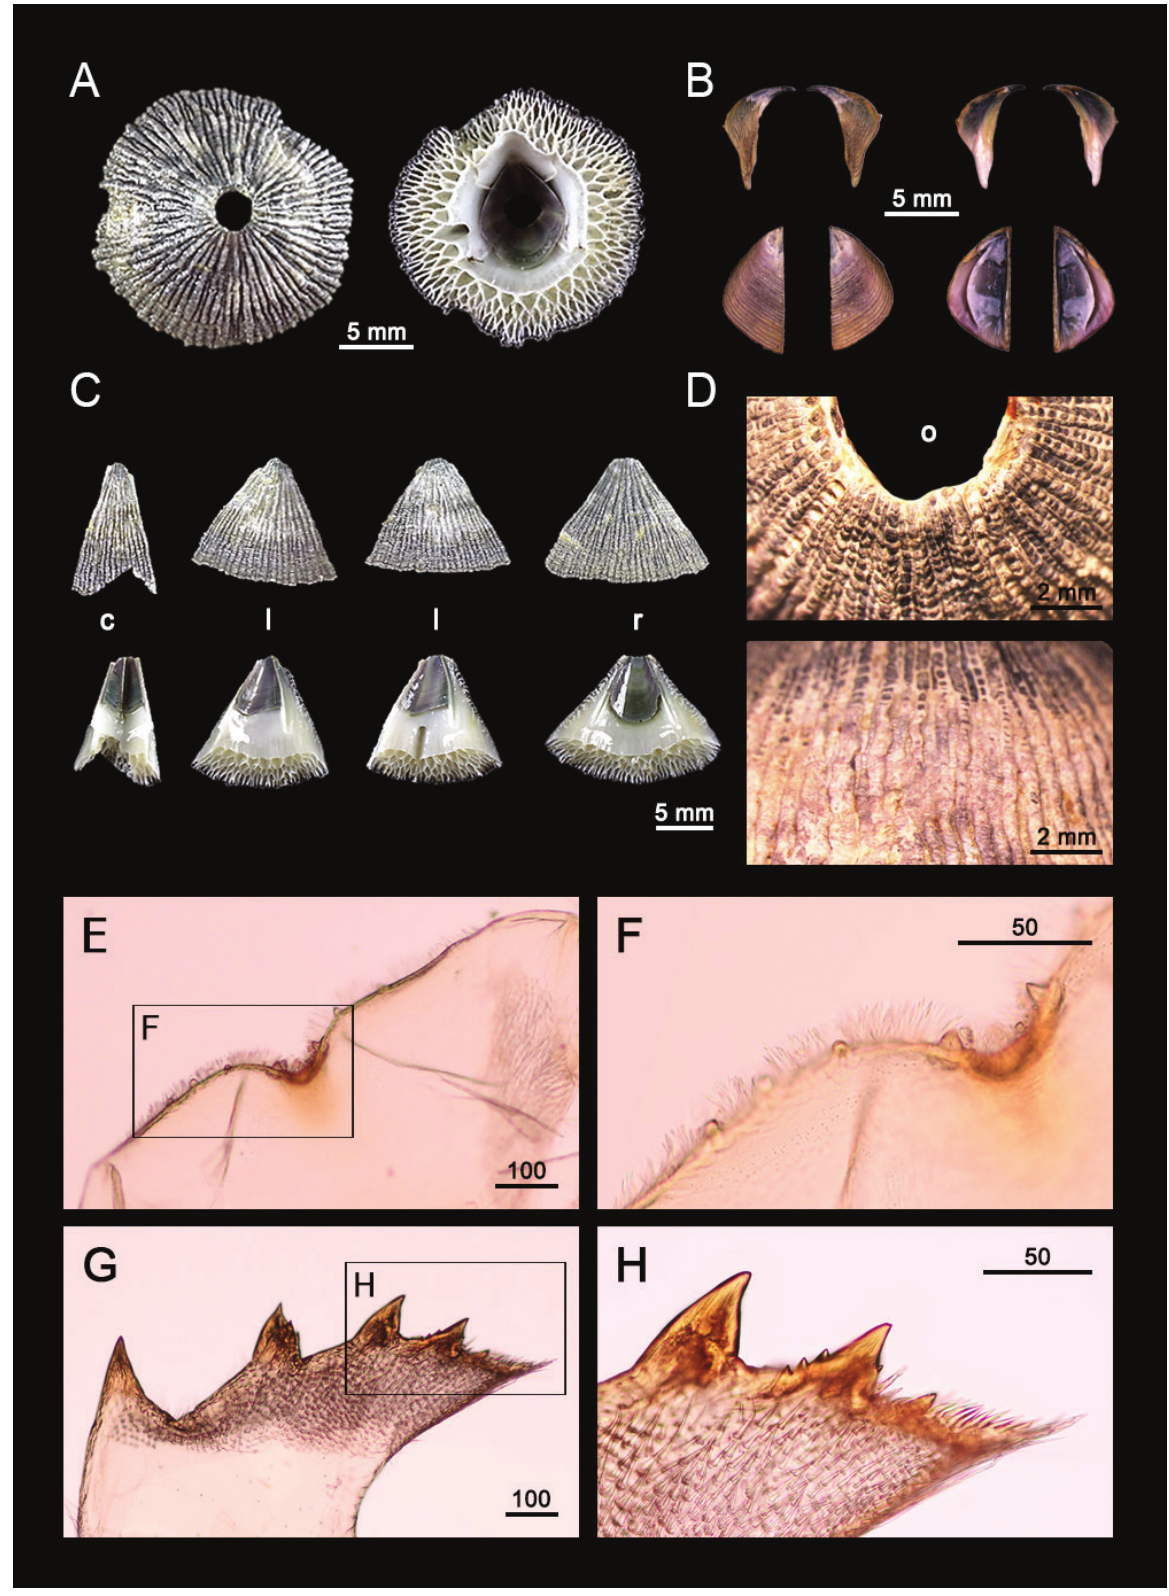
Figure 8. Tetraclita squamosa collected from Hin Ngam beach, Nakhon Si Thammarat (BUU16.TC.TS01). A. Dorsal and ventral view of external shell, B. External (left panel) and internal (right panel) view of tergum (upper panel) and scutum (lower panel), C. External (upper panel) and internal (lower panel) view of shell plates, D. Close up on external surface of shell, E–H. Light microscopy on mouthparts, E. Labrum, E. Close up on the teeth of the labrum, G. Mandible, G. Close up on the pectinated lower margin of mandible. E–H. Scale bars in µm. Abbreviations: c, carina; l, latus; r,